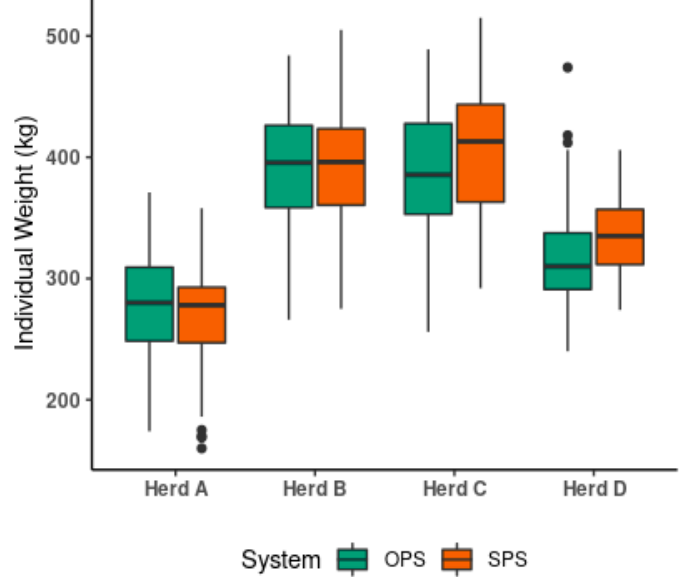
Figure 4. Distribution of individual weights (kg) expressed as percentile ranks for herds and systems. OPS, Open pasture systems; SPS, Silvopastoral systems. Note: The horizontal line in each box is the 50th percentile of the population (the median). Boxplots: boxes with interquartile range and median, whiskers with minimum and maximum dots with extreme values.